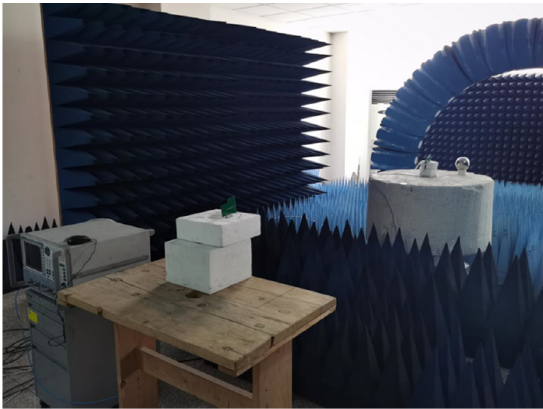
Figure 10. Experiment Ⅱ test scene.